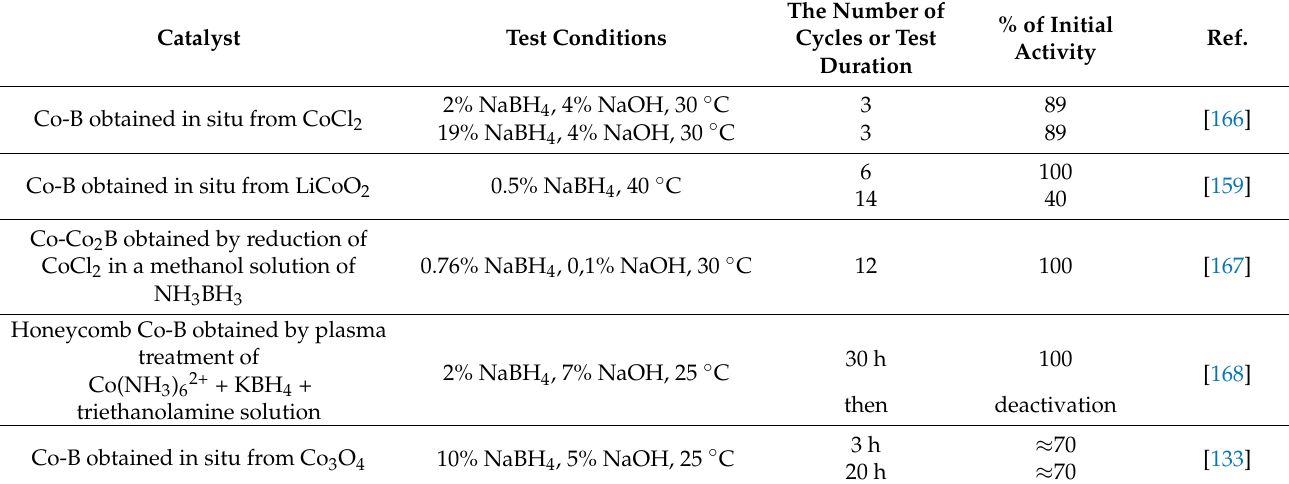
Table 2. Changes in the catalytic activity of bulk and supported Co-B catalysts during their long-term testing in the hydrolysis of NaBH 4